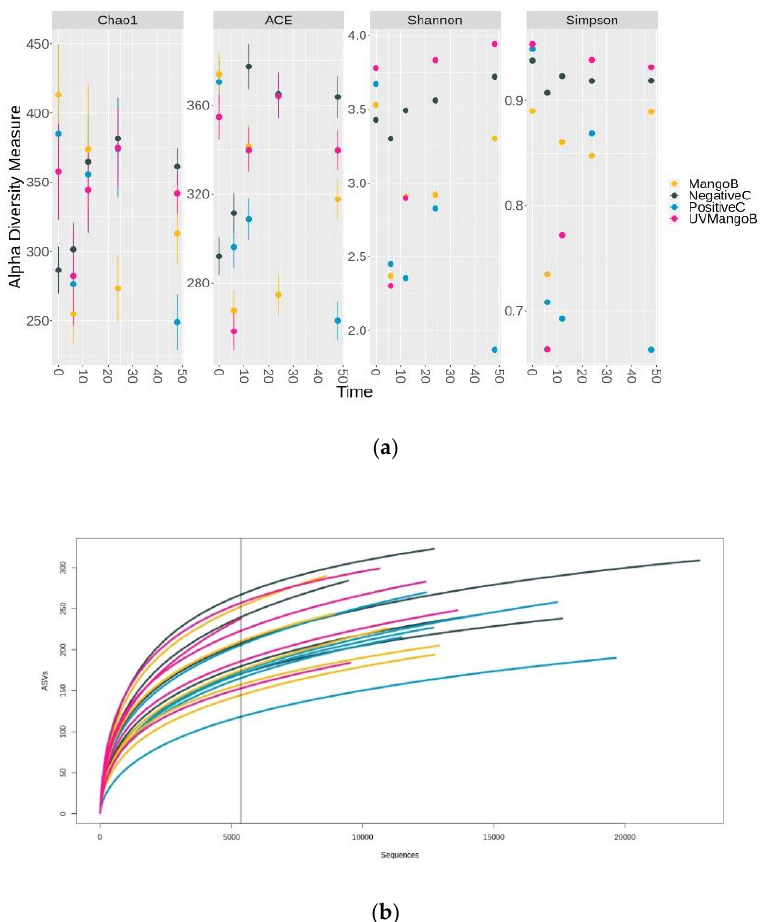
Figure 1. Point chart and rarefaction curves of amplicon sequences variants (ASVs) from in vitro colonic fermentation samples of negative control (NegativeC), positive control (PositiveC), UV-C irradiated mango bar (UVMangoB) and non-irradiated mango bar (MangoB) treatments. ( a ) Alpha-diversity estimators by richness (Chao1 and ACE) and diversity (Shannon and Simpson) indexes of observed species into ASVs at 0, 6, 12, 24 and 48 h of colonic fermentation. ( b ) Rarefaction curves based on the ASVs from colonic fermentation of NegativeC (grey dark), PositiveC (blue), MangoB (yellow) and UVMangoB (pink). The x-axis indicates the number of valid sequences and the y-axis shows the observed species in ASVs. Each curve represents a different monitoring sample and the vertical straight line indicates the minimum number of sequences found in a sample.